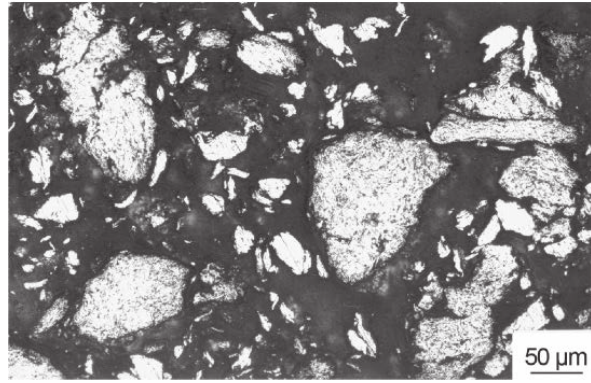
Fig. 2: Dependence of carbon to the carbide transformation rate on heat treatment temperature and holding time for four carbon types